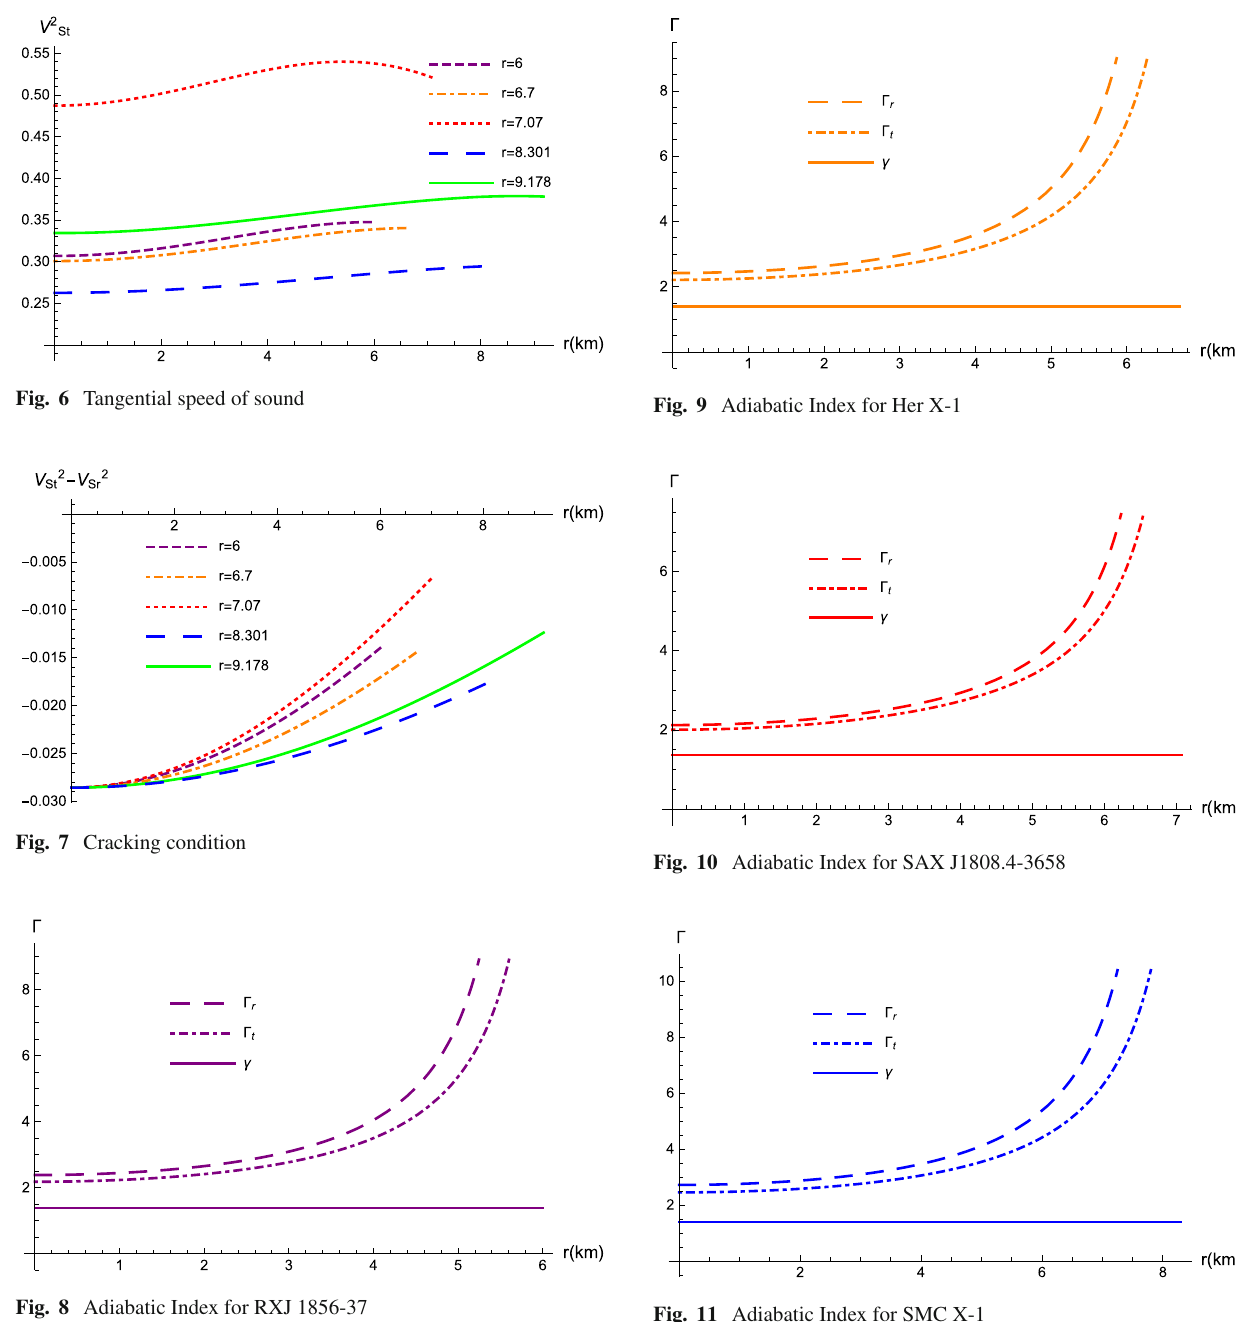
Fig. 11 Adiabatic Index for SMC